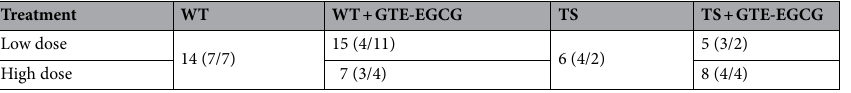
kg/day) of GTE-EGCG in drinking water to TS and wild-type euploid (WT) mice from embryonic (E) day 9 to post-natal (P) day 29 (see Table 1 for sample composition). The GTE-EGCG solution was prepared freshly using the same batch of the Mega Green Tea Extract in all the experiments, with an estimated composition of 53.6% EGCG, 4.5% epicatechin (EC), 9% epicatechin gallate (ECG) and 12.5% epigallocatechin (EGC). Control litters received a control solution (see “Materials and methods” for further details). We quantitatively compared the facial skeletal morphology of TS and WT mice, with and without treatment, using a quantitative shape analysis 32 based on the 3D coordinates of 12 anatomical facial landmarks registered on micro-computed tomographic (µCT) images of mouse craniofacial skeletons (Fig. S1A, Table S2). As sexual dimorphism was not a significant effect (Table 1 and Fig. S2), we performed our analyses on the pooled sample of male and female mice. To assess genotype and GTE-EGCG treatment effects on the murine facial skeleton, we performed a Principal Component Analysis (PCA). We explored facial shape variation among individuals by creating a morphospace based on the first two PCs, which together explained 49.6% of the total morphological variance among samples. In this scatterplot (Fig. 1), each point represented the facial shape of one individual and the experimental groups of mice were outlined using convex hulls. Close proximity between groups indicated similar facial phenotypes, while separation indicated dissimilarity. Our results showed genotype-dependent facial shape differences (Fig. 1). Untreated WT and TS mice clustered in separate morphospace groups with commen- surate ranges of variation (Fig. 1). Compared to WT, TS mice exhibited midfacial hypoplasia and reduced facial dimensions, which corresponds to human trisomy 21 phenotypes (Fig. S3).